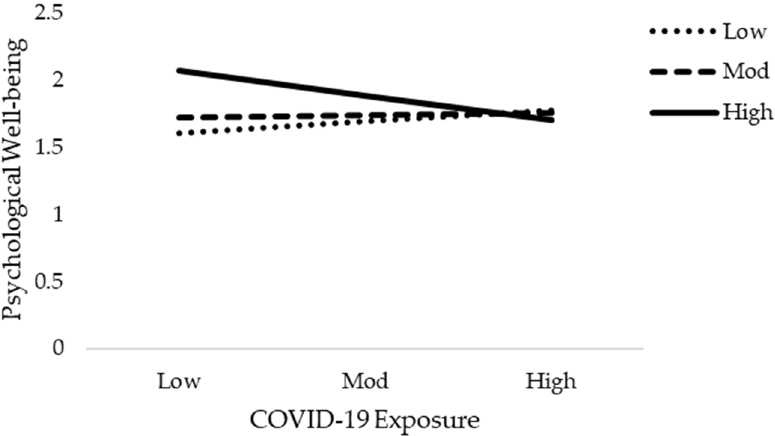
Figure 9. Interactive effect of COVID-19 Exposure and social support on Psychological Well-being.